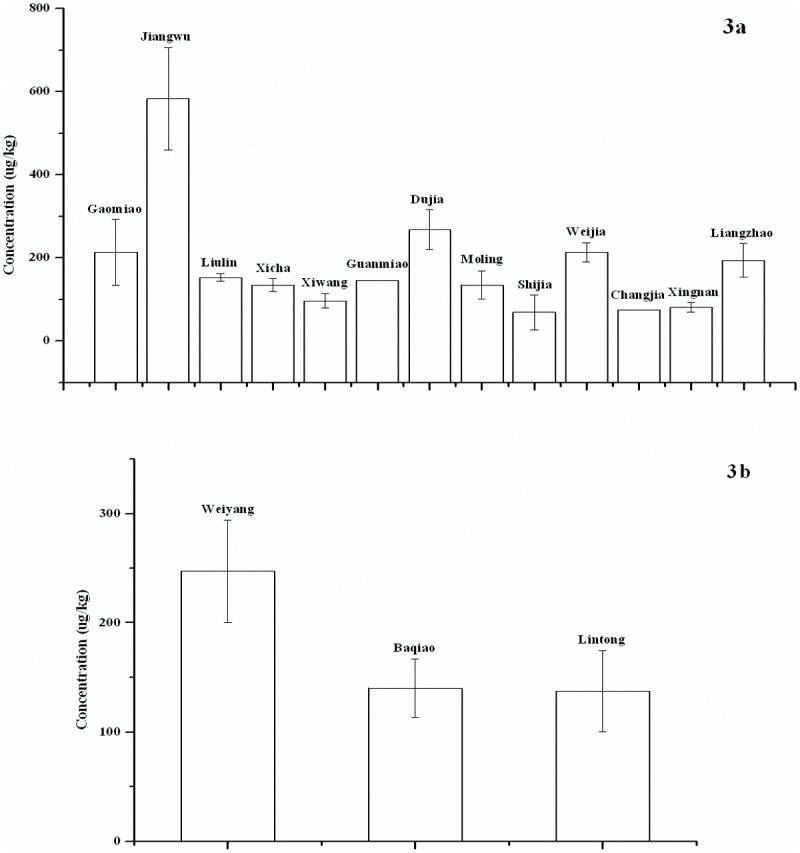
PAHs in soil among 13 sampling areas (a) and three regions (b).